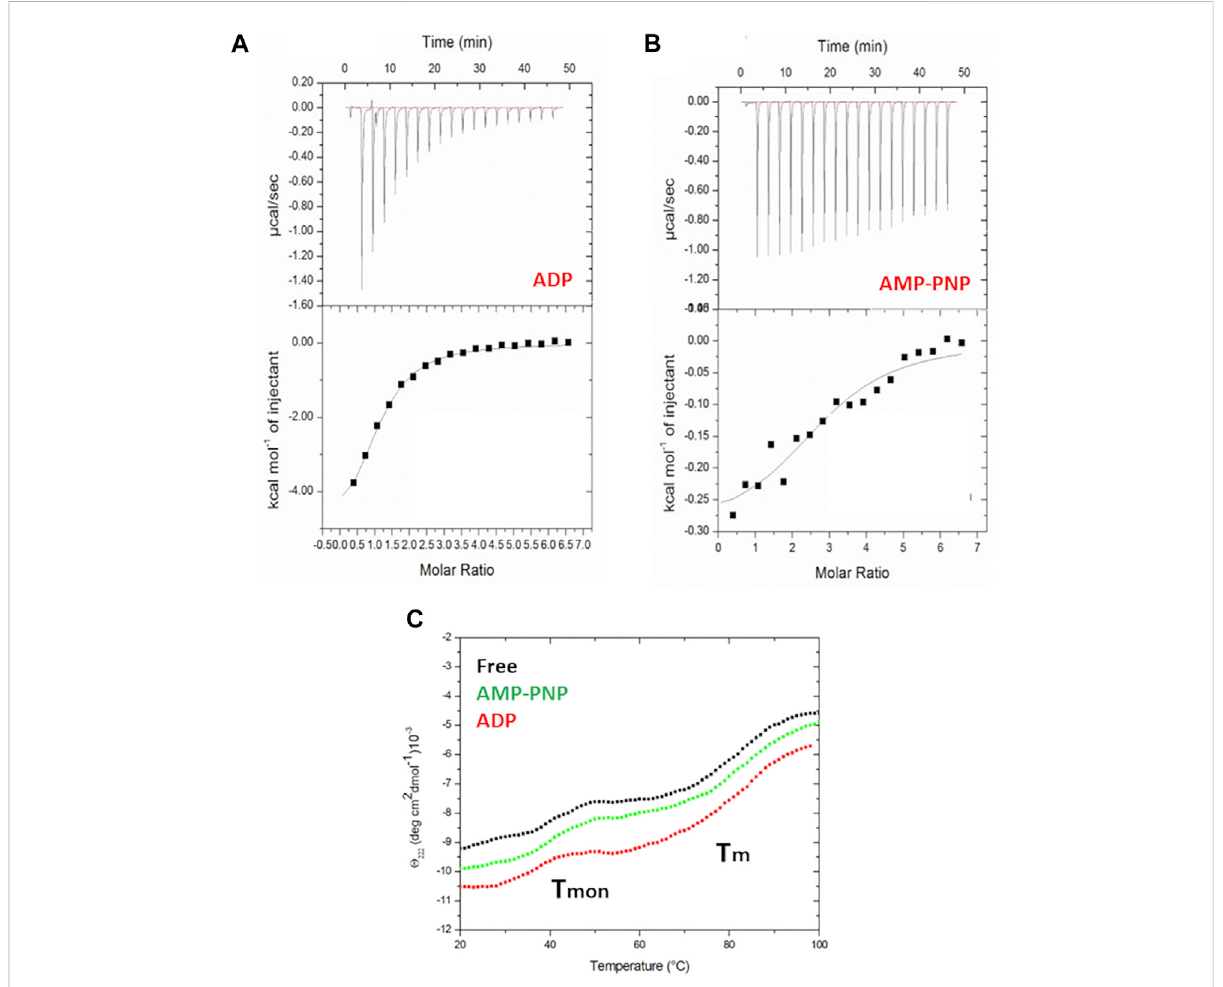
FIGURE 2 Isothermal titration calorimetry of HtpG Mtb wild type with ADP (A) and AMP-PNP (B) . Top panels report raw data for the titrations at 22 ° C, whereasbottompanelsreportintegratedheatsofbindingobtainedfromtherawdataaftersubtractingtheheatsofdilution.Thesolidlinesinbottom panelsrepresentthebestcurve fi tstotheexperimentaldatausingthe ‘ onesetofsites ’ modelfromMicroCalOrigin. (C) Thermaldenaturation curves of HtpG Mtb with and without nucleotides (AMP and AMP-PNP), monitored at 222 nm in 20 mM sodium phosphate (pH 7.4).